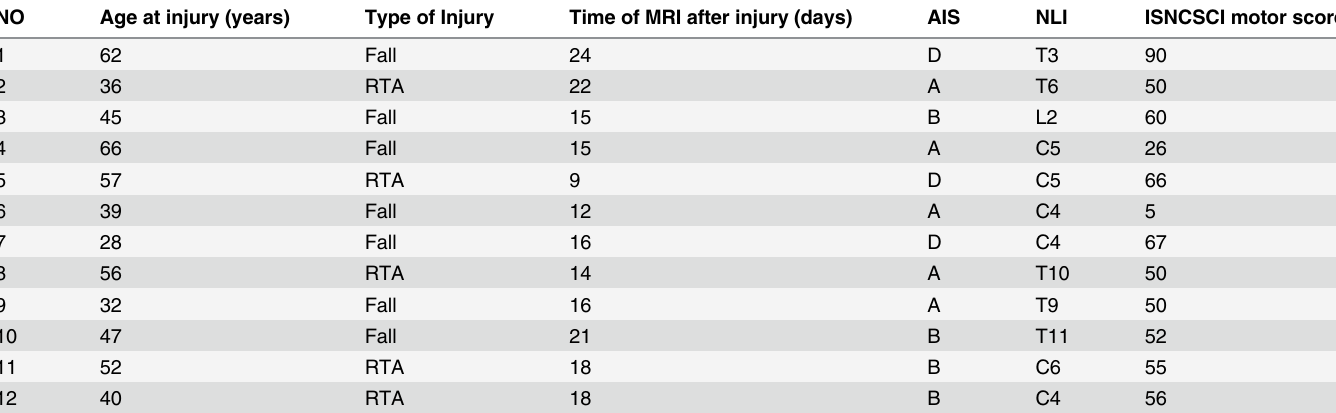
Table 1. Demographic and clinical information of patients with acute spinal cord injury.